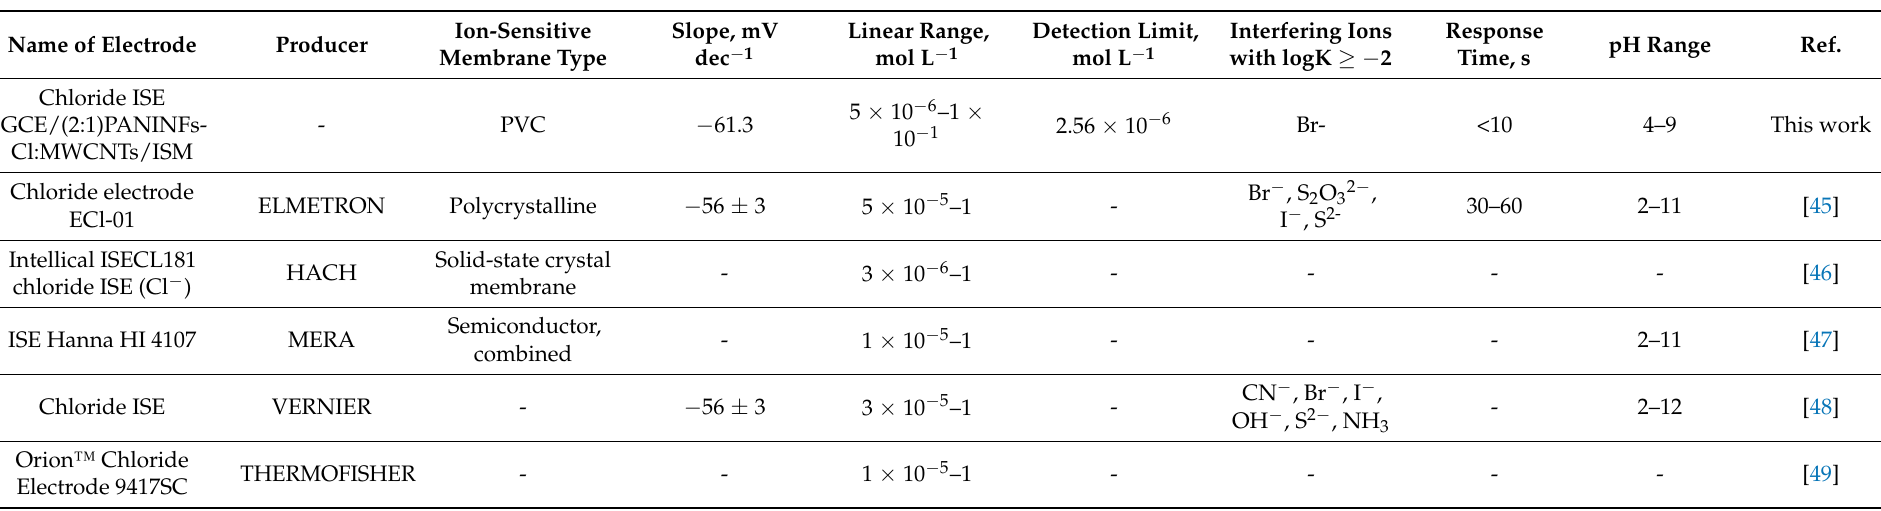
Table 7. Comparison of the parameters for the tested chloride electrodes and commercially available